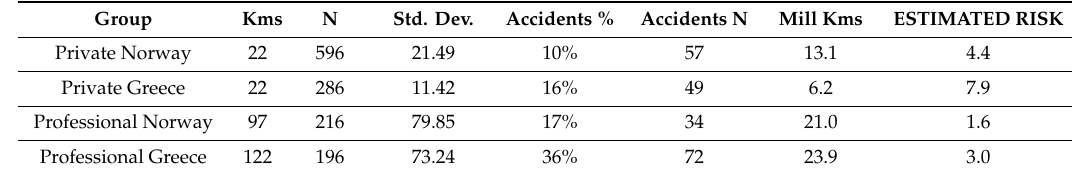
Table 4. Estimated mean thousand kilometers (Kms) driven in the last two years with a car or heavy vehicles, including share and number of respondents who answered that they had experienced an accident in the last two years, total number of million kms, and estimated risk of accidents with property damage, based on self-reported numbers of kilometers and accidents. Group Kms N Std. Dev. Accidents % Accidents N Mill Kms ESTIMATED